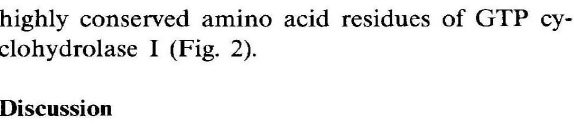
Figure 2. Comparison of amino acid sequences of human (8), rat (7), and mouse (9) GTP cyclohydrolase I's. Amino acids identical with those of human GTP cyclohydrolase I are indicated by hyphens. Positions of aberrant GTP cyc1ohydrolase I residues found in patients with GTP cyc1hydrolase I deficiency (14,15) and in patiens with HPD/DRD (10) are emphasized by the larger letter with the position mumber at the top of the human